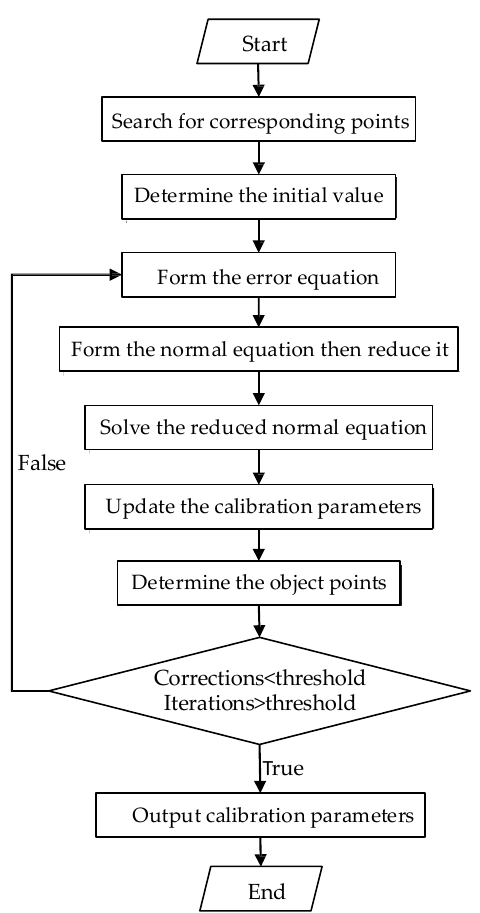
Figure 2. Proposed processing procedure of distortion detection without using ground control points (GCPs).